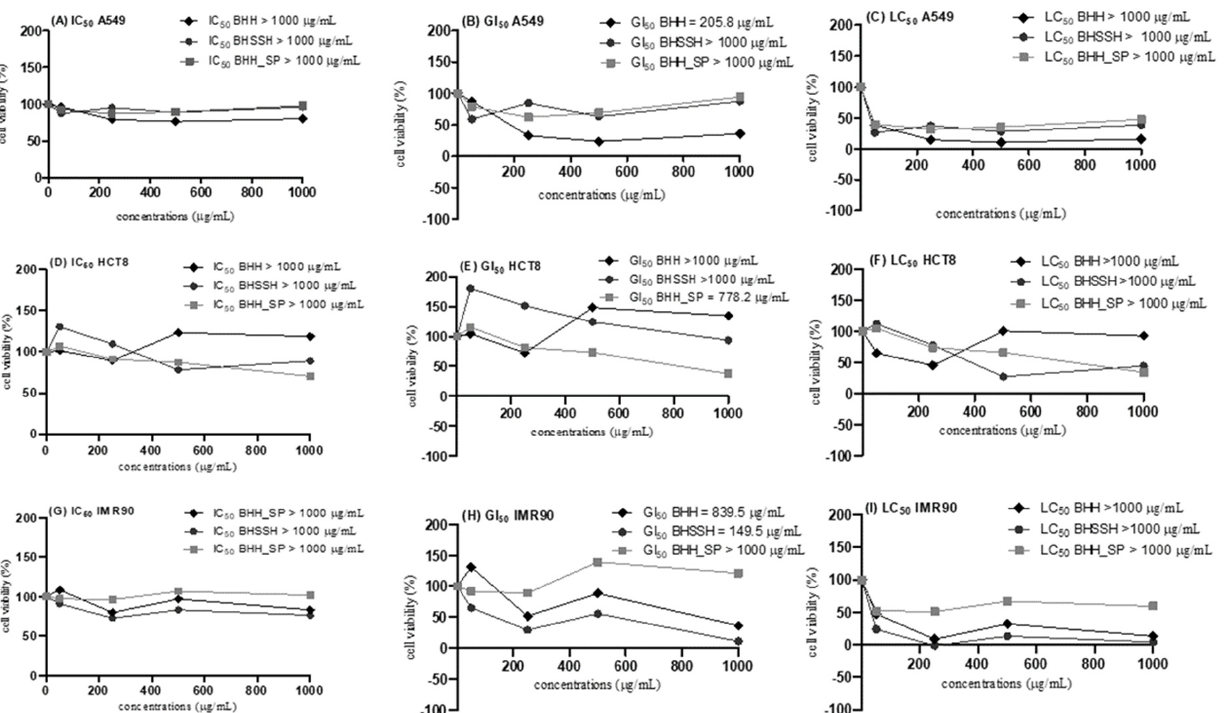
Figure 2. Cell viability and proliferation evaluation of the concentration-dependent effect after 48 h exposure to BHH, BHSSH and BHH_SP extracts in IMR90, A549 and HCT8 cell lines. ( A , D , G ) IC 50 (concentration of the extracts that inhibits cell viability by 50%); ( B , E , H ) GI 50 (concentration of the extracts inhibits cell growth by 50%); and ( C , F , I ) LC 50 (concentrations of the extracts that result in the loss of 50%